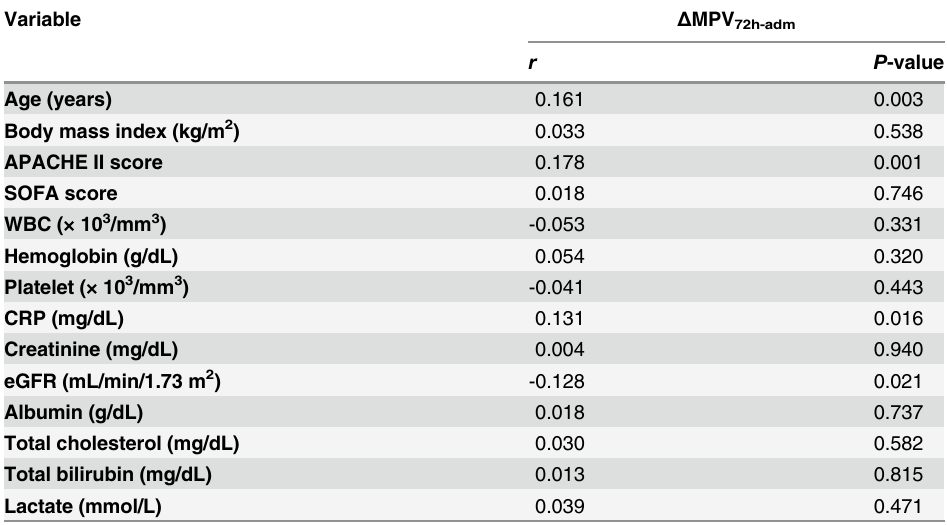
Table 3. Correlation between Δ MPV 72h-adm and